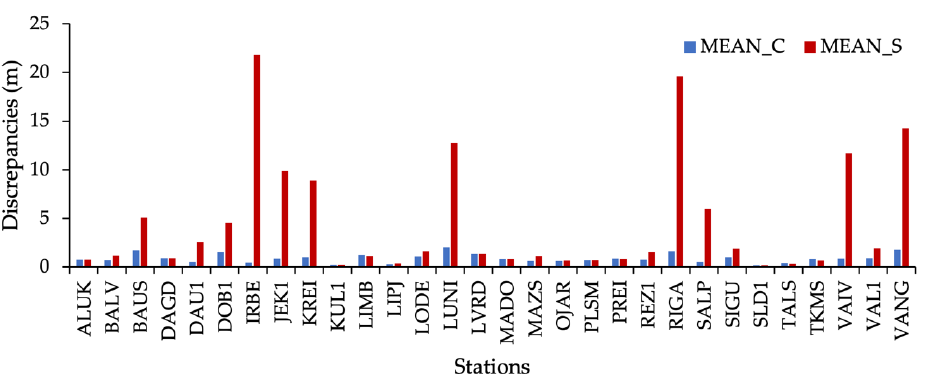
Figure 7. Mean discrepancies for ‘calm’ days (MEAN C) and for storm day, 17 March (MEAN S). The fluctuation of the discrepancies during the St. Patrick’s Day geomagnetic storm in meters were as follows for Northing [ −1 30.511; 106.922], Easting [ −7 4.896; 120.517], and Up [ −5 31.624; 154.625].